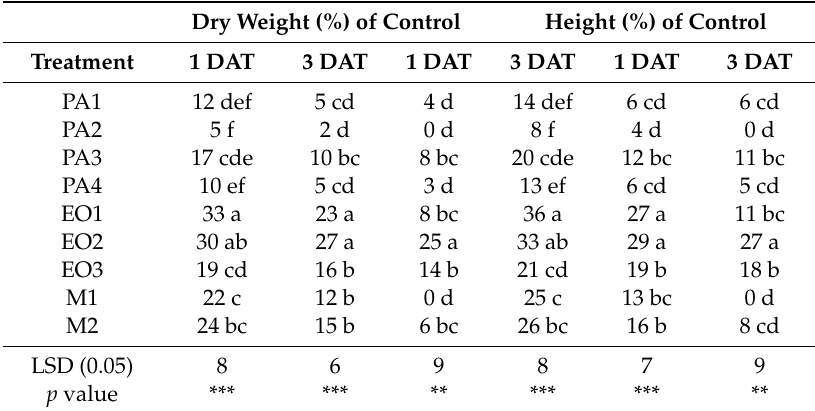
Table 5. Dry weight and height of G. aparine plants as a ff ected by the application of the natural herbicides at 1, 3 and 7 days after treatment (DAT). Dry weight and height values of G. aparine plants is expressed as % of